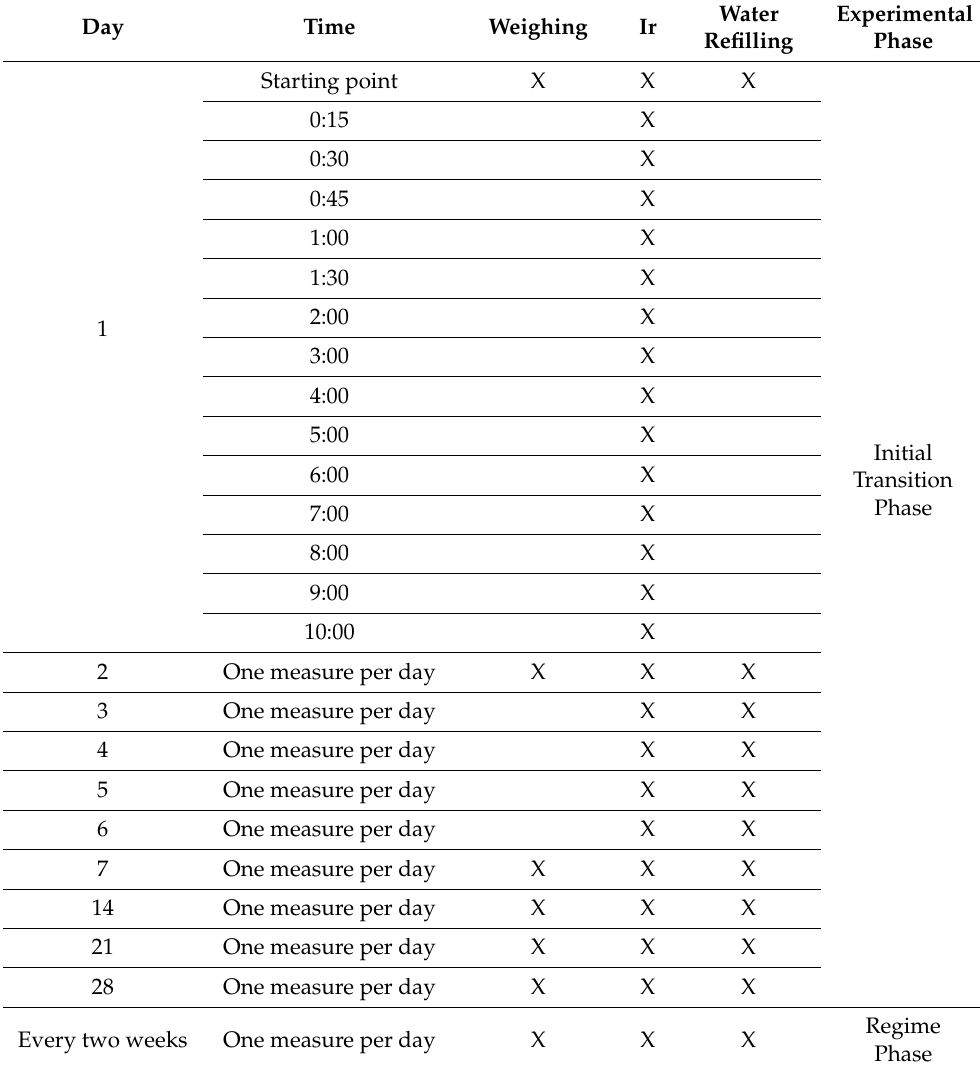
Water Refilling